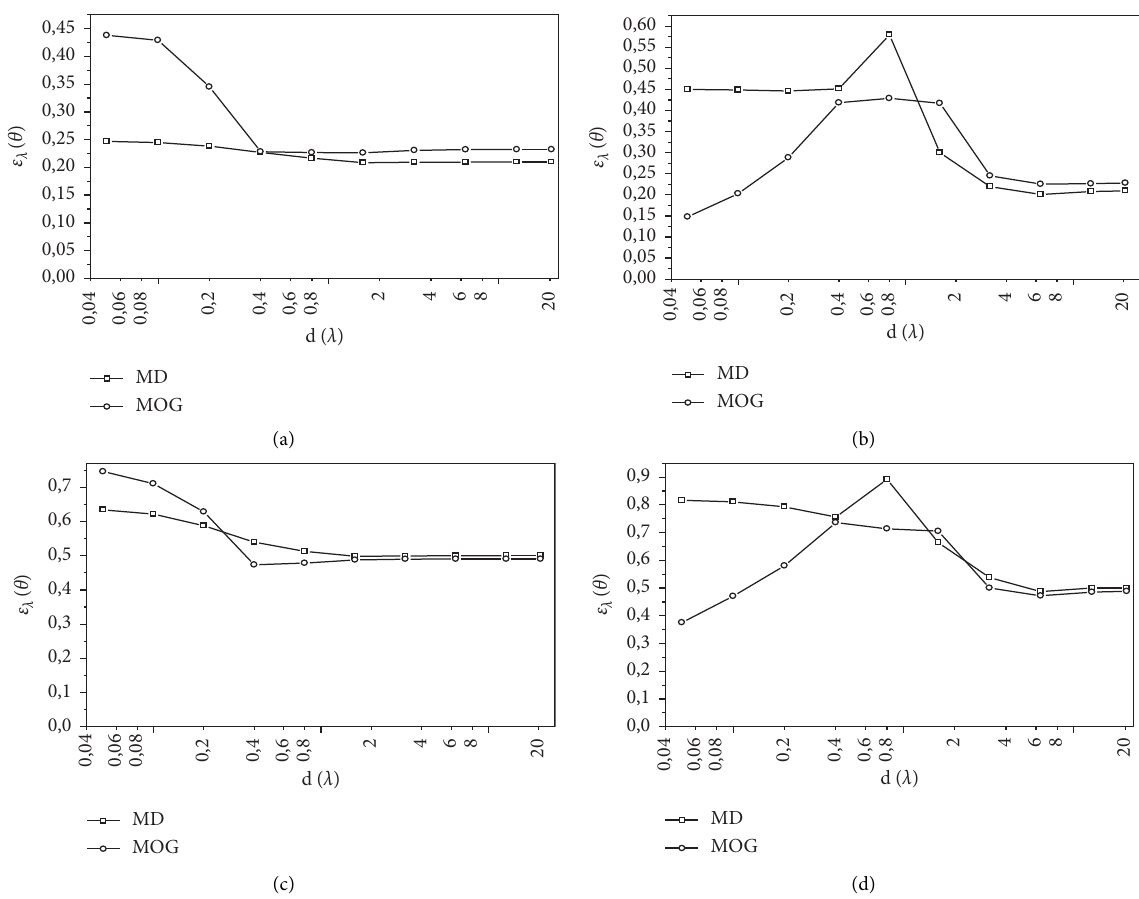
Figure 1: Emissivity as a function of d / λ parameters: (a) Or: h � 0 . 1 λ and θ � 10 ° ; (b) gold: h � 1 λ and θ � 10 ° ; (c) tungsten: h � 0 . 1 λ and θ � 10 ° ; (d) tungsten: h � 1 λ and θ � 10 °